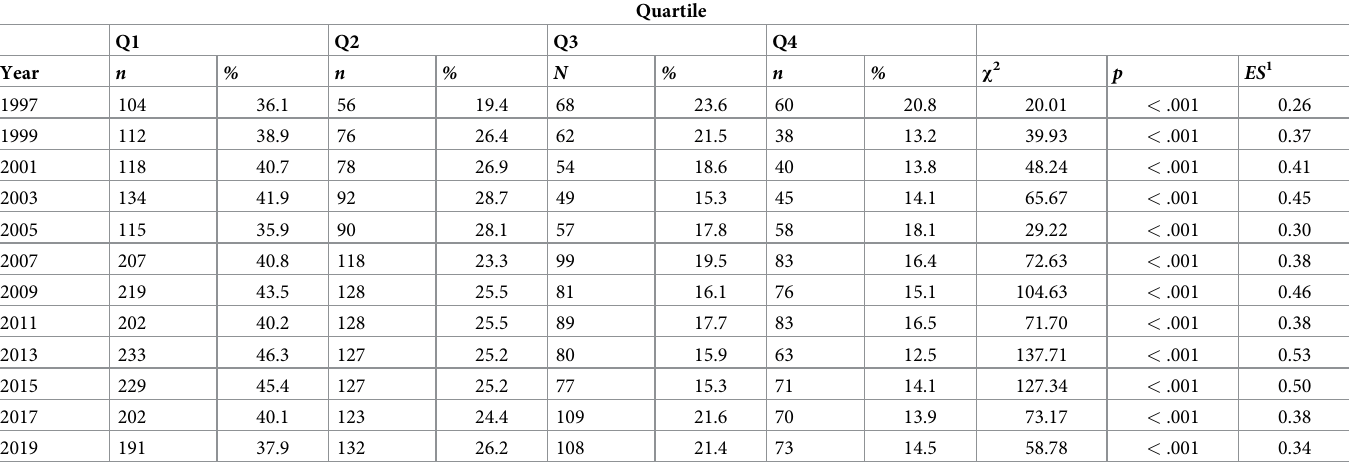
Table 2. Distribution of birth dates in male soccer players participating in the under-17 world cup from 1997–2019.